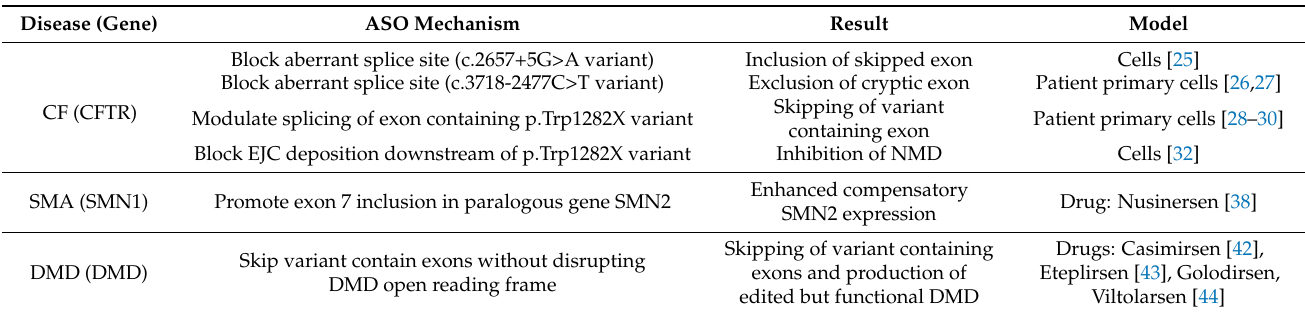
Table 1. Summary of Important Advances in ASO technology in monogenic diseases